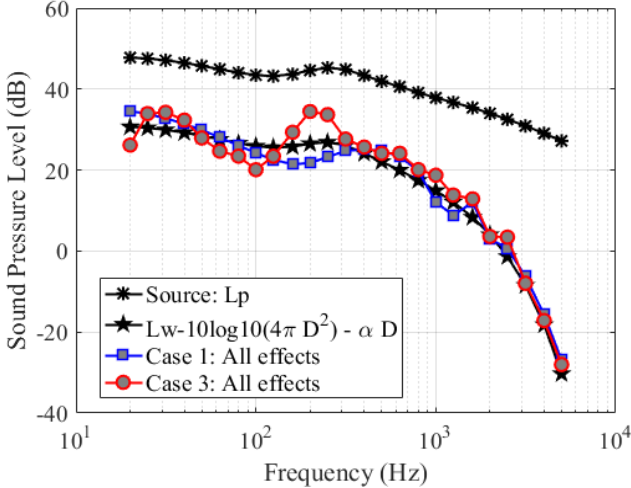
Figure 15. SPL of wind turbine #1 (Source: Lp) received at 1500 m distance (2 m height): with geometric attenuation and air absorption, Case 1 and Case 3 with all propagation effects.